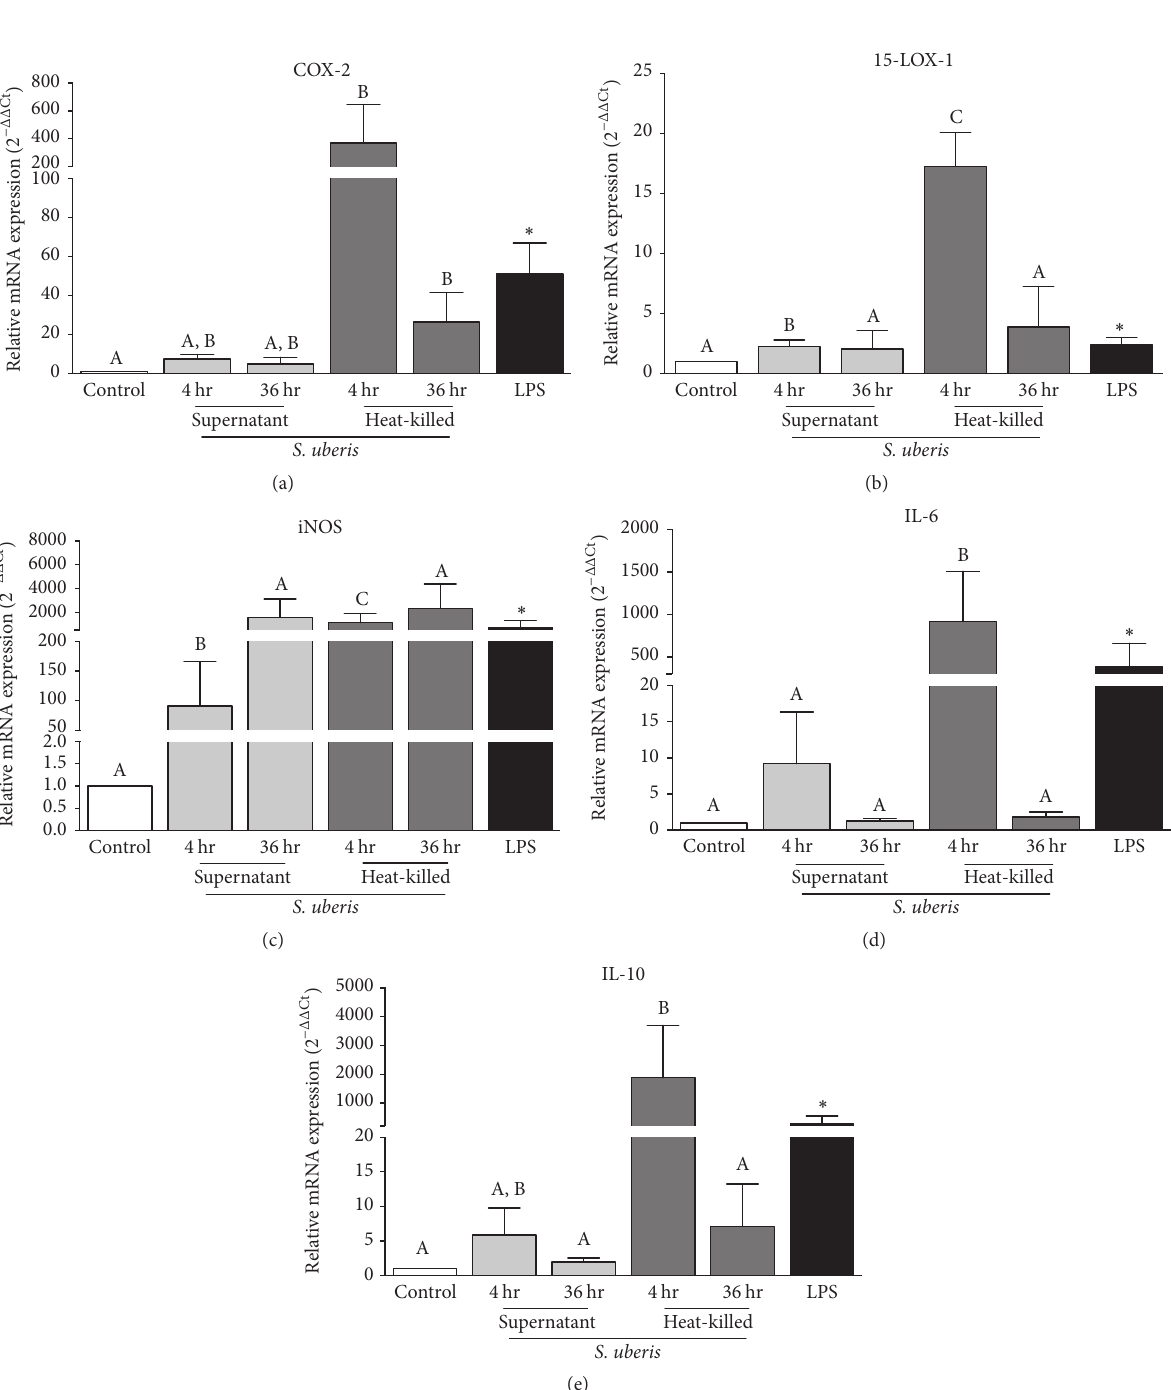
Figure 3: Mean changes in mRNA expression of bovine monocyte oxylipid biosynthetic enzymes (a, b), a marker of monocyte activation (c), and inflammatory cytokines (d, e). Media controls are displayed as open bars. Positive control is 4 hr LPS and displayed in closed bars. Light grey bars represent S. uberis supernatant exposure for 4 hr and 36 hr. Dark grey bars represent heat-killed S. uberis exposure for 4hr and 36 hr. The mRNA expression is expressed as 2 −ΔΔ Ct ± SE. Asterisks ( ∗ ) denote differences between media control and positive control (LPS) as tested by Student’s t -tests. Letters that differ between control time points, 4 hr and 36hr separately, denote significant differences between control and among treatments as measured by an ordinary one-way ANOVA with Tukey’s post hoc correction. For example, 4hr exposure to heat-killed S. uberis upregulated COX-2 mRNA expression compared to control but 4 hr exposure to S. uberis supernatant did not (a). Additionally, COX-2 mRNA expression after heat-killed S. uberis exposure is not different from COX-2 mRNA expression after S. uberis supernatant exposure (a). A similar relationship can be described for 36hr exposure of bovine monocytes to heat-killed and S. uberis supernatant. Significance declared for all tests using Δ Ct at P ≤ 0.05 ( 𝑛 = 4 for 15-LOX-1, IL-6, and IL-10; 𝑛 = 3 for COX-2 and